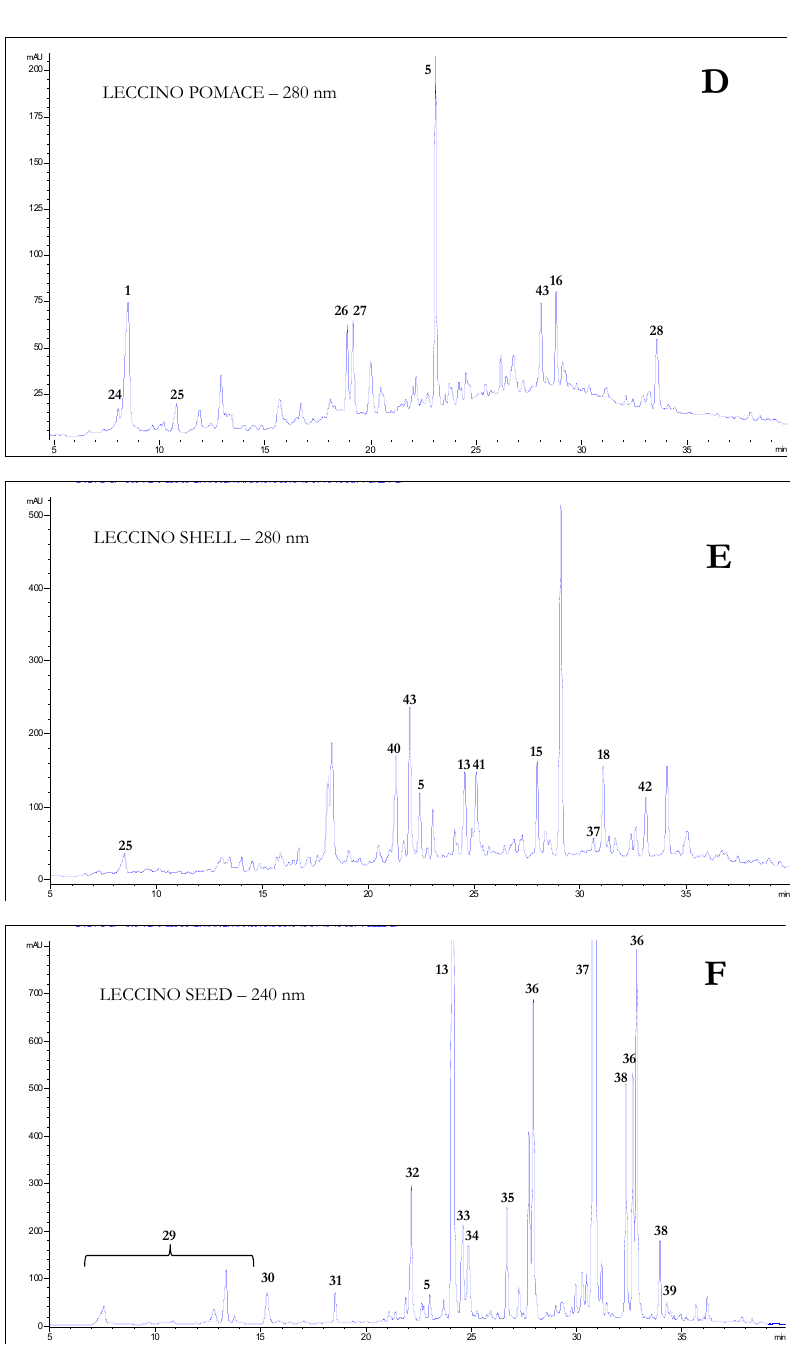
Figure 1. Chromatographic profiles at 280 nm of the phenolic compounds in Leccino cultivars: ( A ) Leaves, ( B ) Branches, ( C ) Fruits, ( D ) Pomace, ( E ) Shell and at 240 nm for ( F ) Seeds. 1, hydroxytyrosol; 2, taxifolin glucoside isomer; 3, esculetin; 4, eriodictyol-7- O -glucoside isomer; 5, verbascoside; 6, luteolin-7- O -glucoside; 7, taxifolin isomer; 8, oleuropein diglucoside (+comselogoside